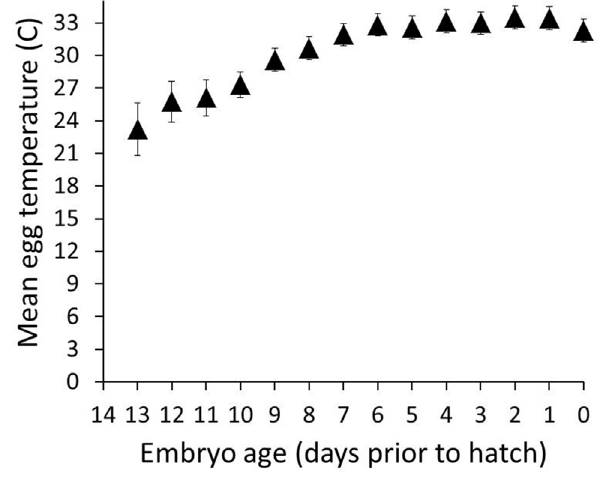
Figure 4. Mean daily egg temperatures. Mean daily egg temperatures ( u C) steadily increased over the incubation period until consistently near or above the assumed physiology zero temperature (PZT) of 24–27 u C (dashed lines). This pattern is consistent with the hypothesis that embryo thermal tolerances narrow as embryo’s age.